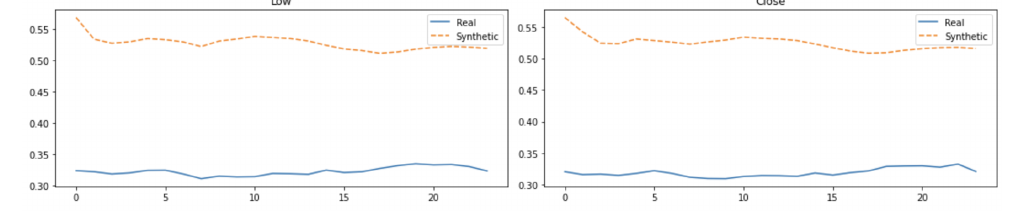
Figure 6. Synthetic and real data for low and close columns.